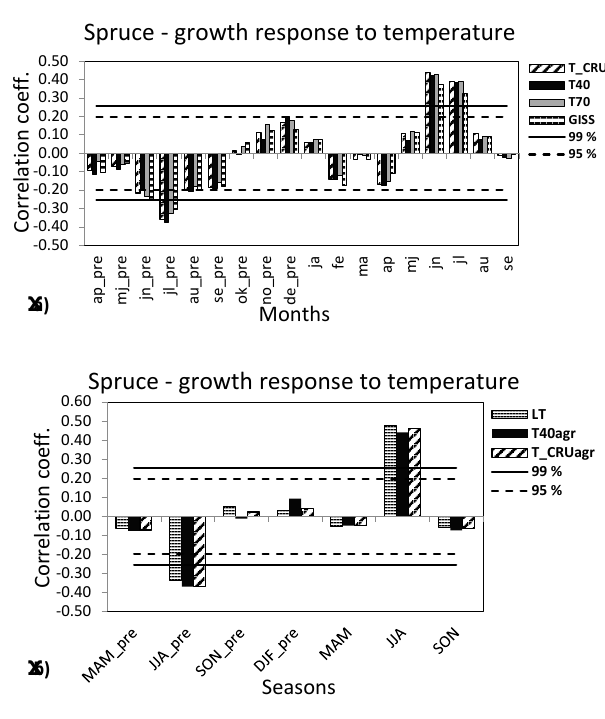
Figure 4. Growing response of spruce radial increment to data sets of (a) monthly mean temperature, (b) seasonal mean temperature.